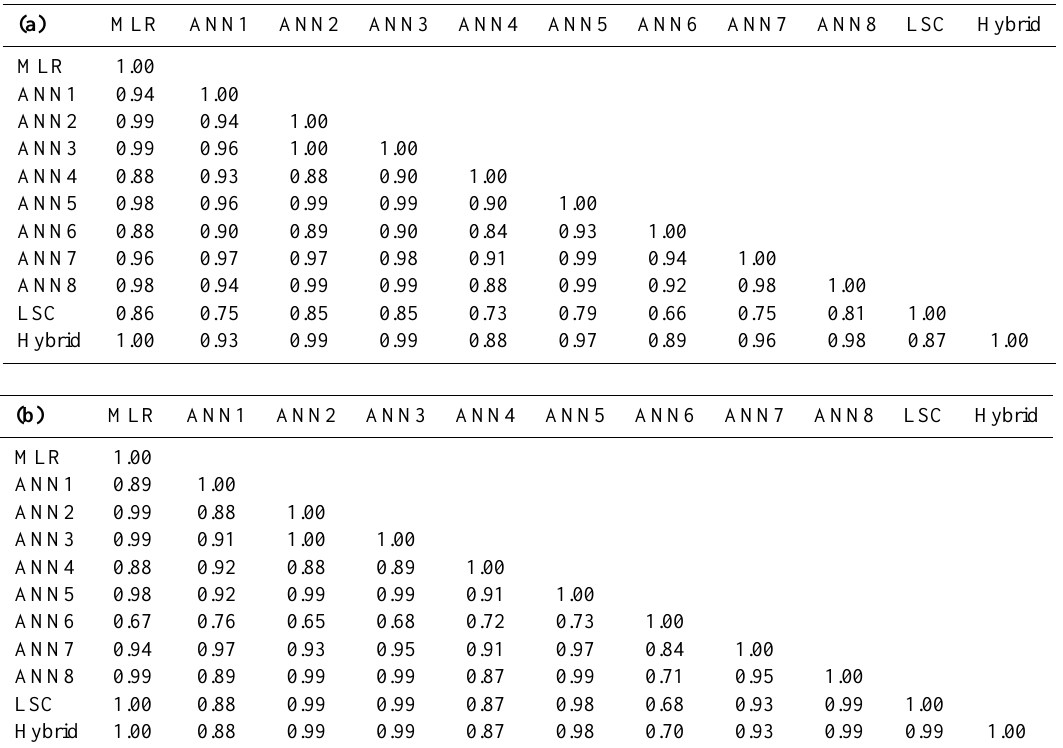
Table 1. Pearson correlations (AD 802–1998) between the reconstructions by multiple linear regression (MLR), different algorithms of artificial neural network (ANN), linear scaling (LSC), and hybrid MLR. Correlations were calculated separately for total range of variability (a) and at decadal and multi-decadal time-scales (b). The latter time series were produced by smoothing them using 15-year cubic splines (with 50 percent cut-off). Mean inter-series correlations were 0.92 (a) and 0.90